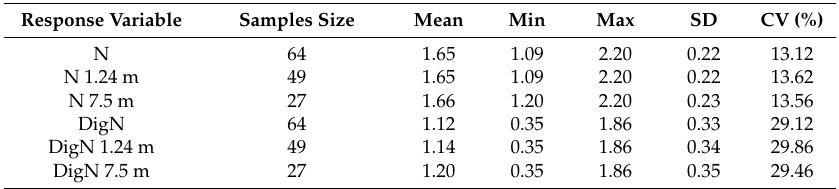
Table 3. DigN and N concentrations (% dry matter) of all samples, sample subsets for WorldView-3 images at 1.24 m and 7.5 m spatial